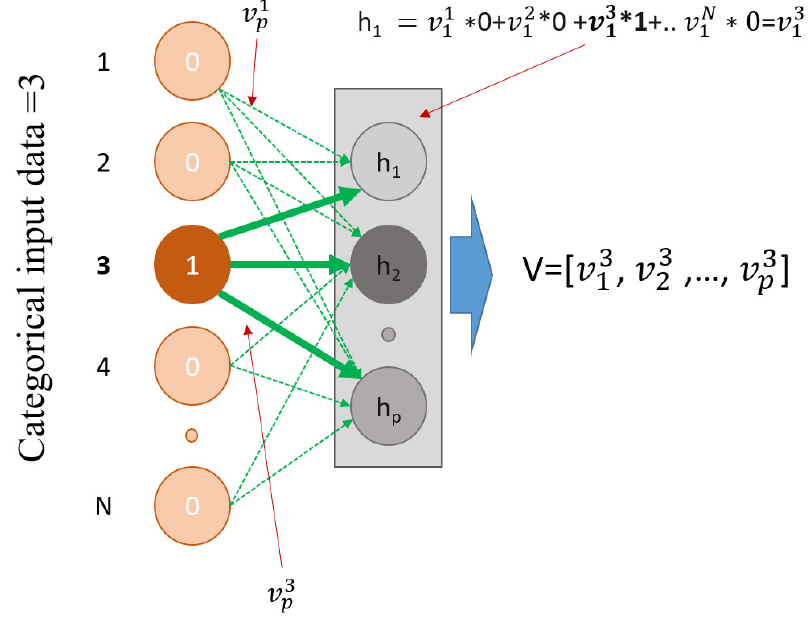
Figure 3. Example of calculating the embedding for item = 3.